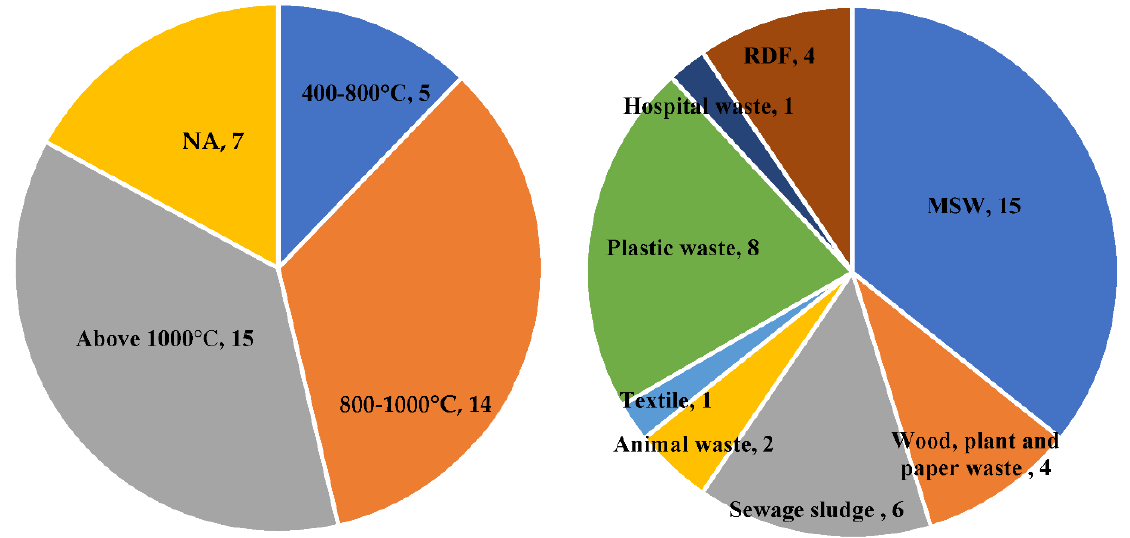
Figure 1. Dioxin measurements, based on different substrates that have been gasified and the operational temperature in the reviewed literature. Dioxin measurements from gasification of different substrates in lab-, pilot-, and full-scale studies (papers from 1990 – 2021). The pie-charts illustrate the number of times that researchers tried to measure dioxin for each substrate type (chart on the right); and the number of times that dioxin was measured for each substrate. type gasified based on the temperature. The total number of occurrences is greater than the number of articles because several articles discuss more than one substrate type. The selections cover all the reports in the literature measuring dioxin in gasification.